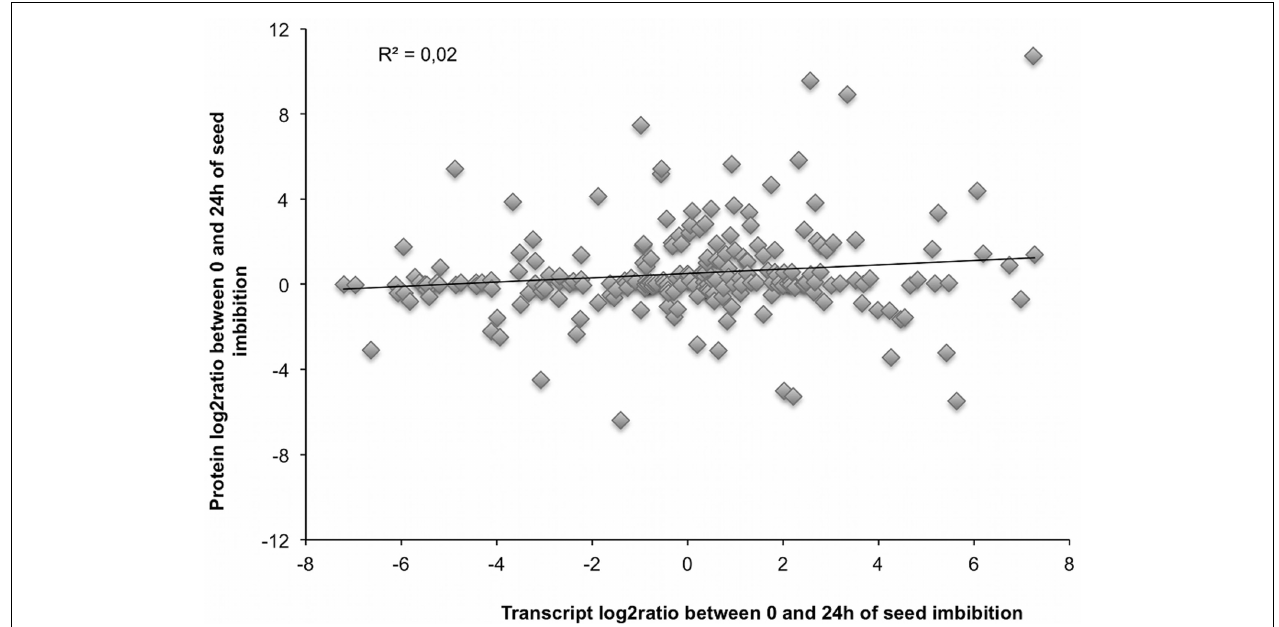
FIGURE 5 |The transcript and protein abundance variation during seed germination are poorly correlated. From the 475 different proteins of the seed proteome, we identified 241 non-redundant proteins (241 AGI).The transcript normalized abundance of 218 of these proteins was retrieved in the